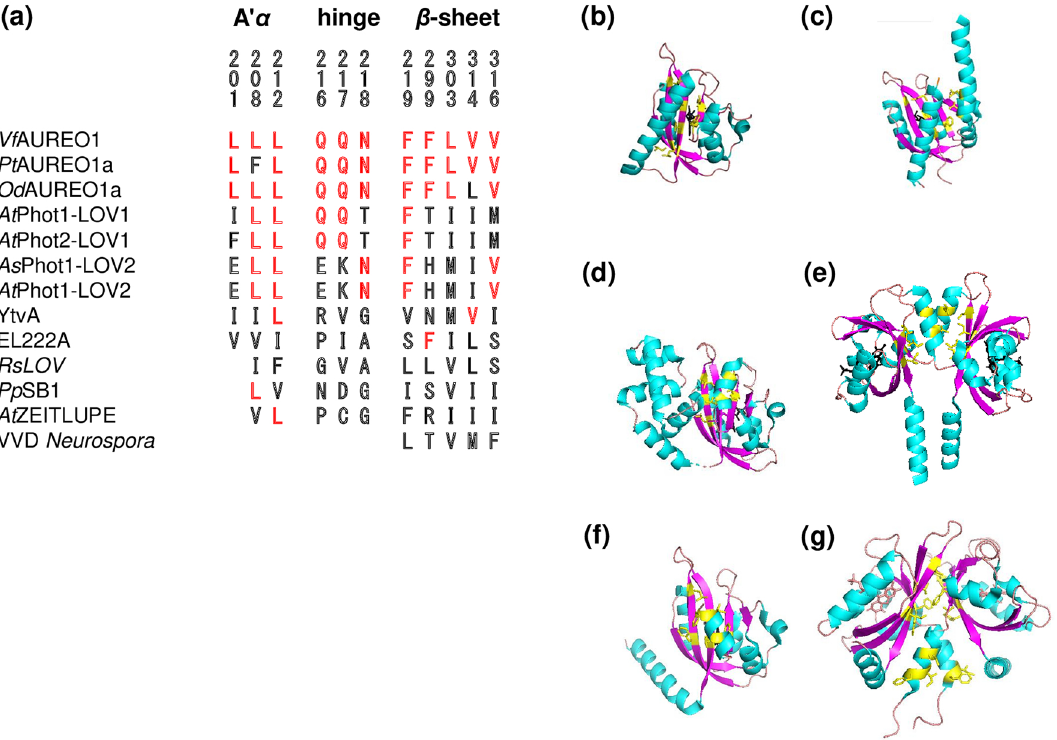
Figure 6. ( a ) The amino acids of Vf AUREO1 investigated in this study, aligned with those of other LOV proteins. Amino acids shown in red represent residues identical to those of Vf AUREO1. Structures of ( b ) As LOV2 (PDB:2V0U), ( c ) Pt Phot1-LOV2 (PDB:4HHD), ( d ) EL222 (PDB:3P7L), ( e ) PpSB1 (PDB:5J4E), and Vf AUREO1 in the ( f ) dark (PDB:5DKK) and ( g ) light (PDB:5DKL) states. Amino acids shown in yellow correspond to the hydrophobic residues in the β -sheet and A’ α